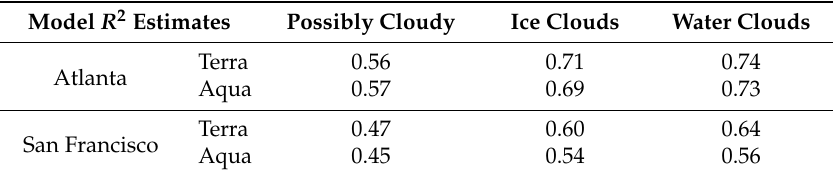
Table 3. Model R 2